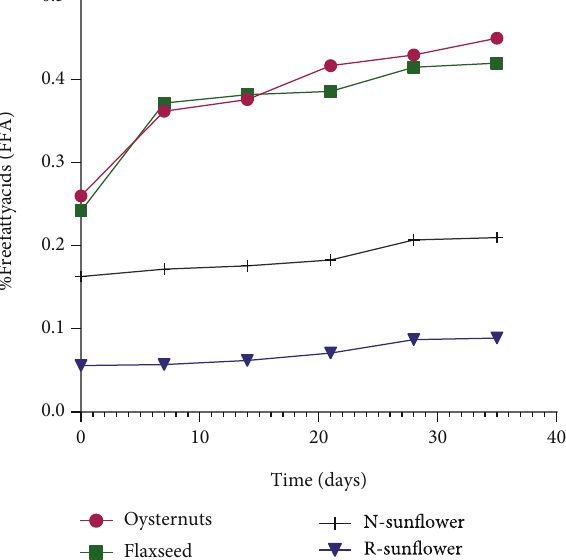
Figure 2: Line graphs showing variations in free fatty acid (FFA) of oyster nut oil, fl axseed oil, re fi ned sun fl ower oil, and nonre fi ned sun fl ower oil samples stored at 25 ° C for a 40-day